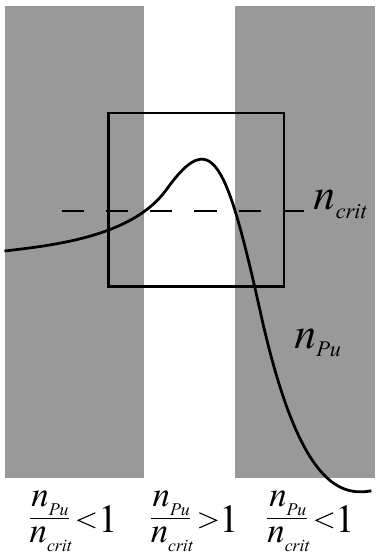
Figure 2. The schematic view of the permitted and subbarier (gray colored) region corresponding to the conditions n by square region is considered more particularly in Figure 3.